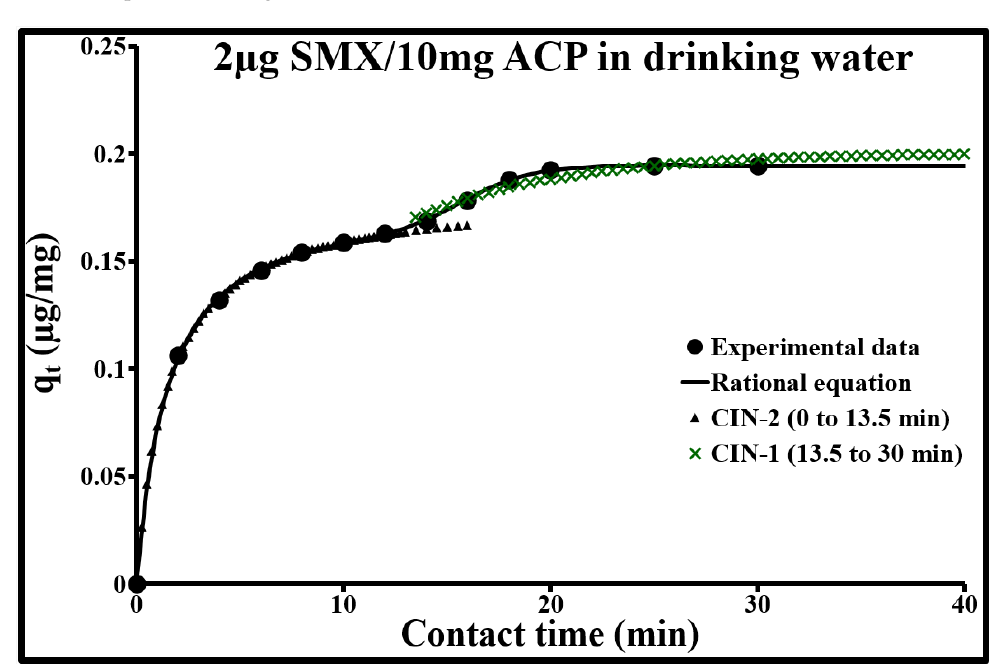
Figure 9. Modeling of the adsorption kinetics of 2 µg/L of SMX per part.